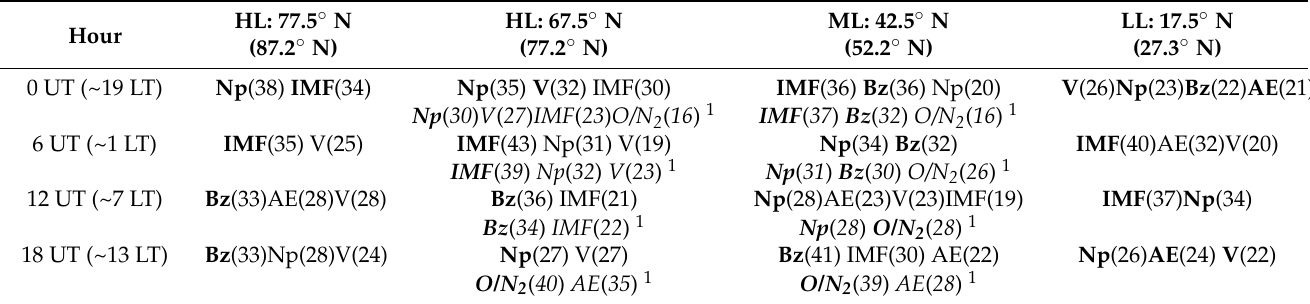
Table 3. Main contributors to foF2(rec) at four latitudes estimated for different hours of the day. HL: 77.5 ◦ Hour